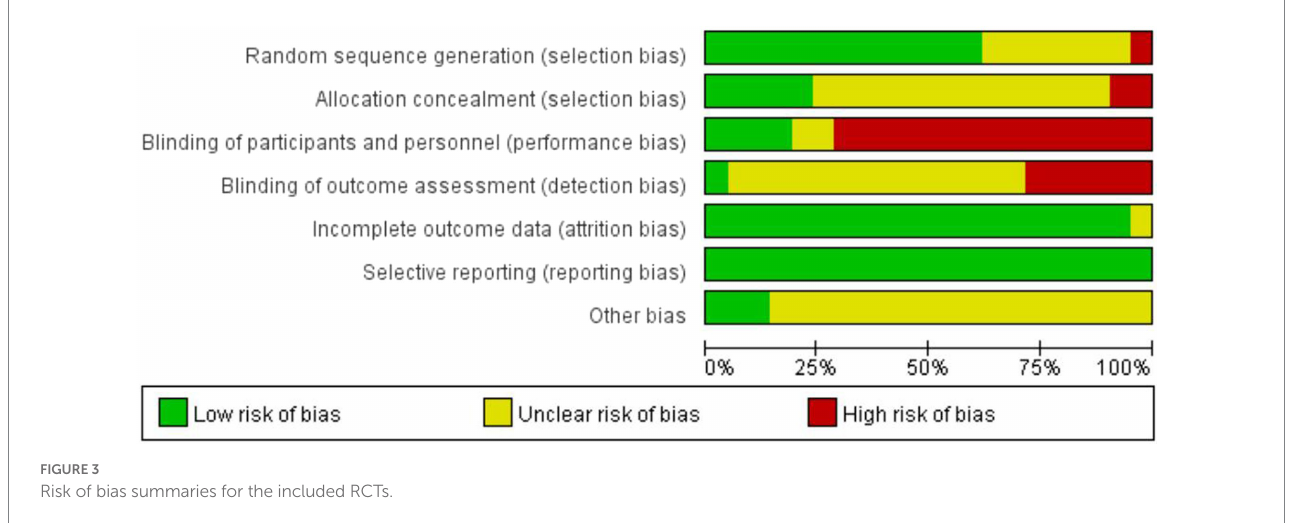
FIGURE 3 Risk of bias summaries for the included RCTs.